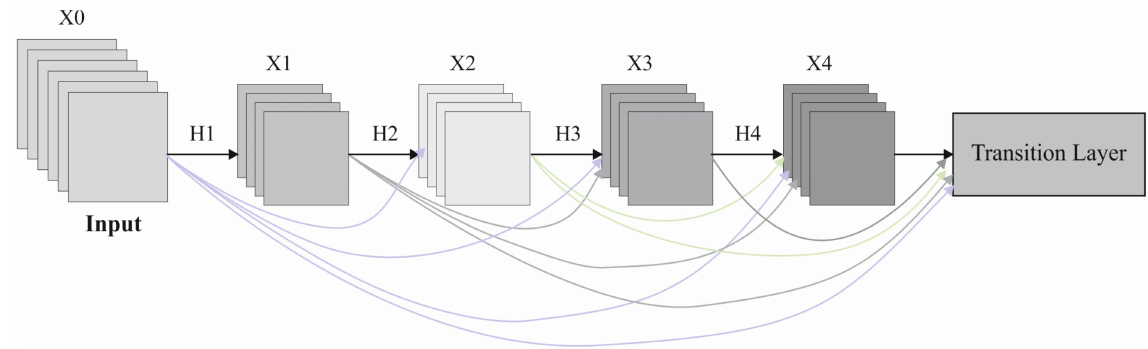
Figure 2. Overall architecture of